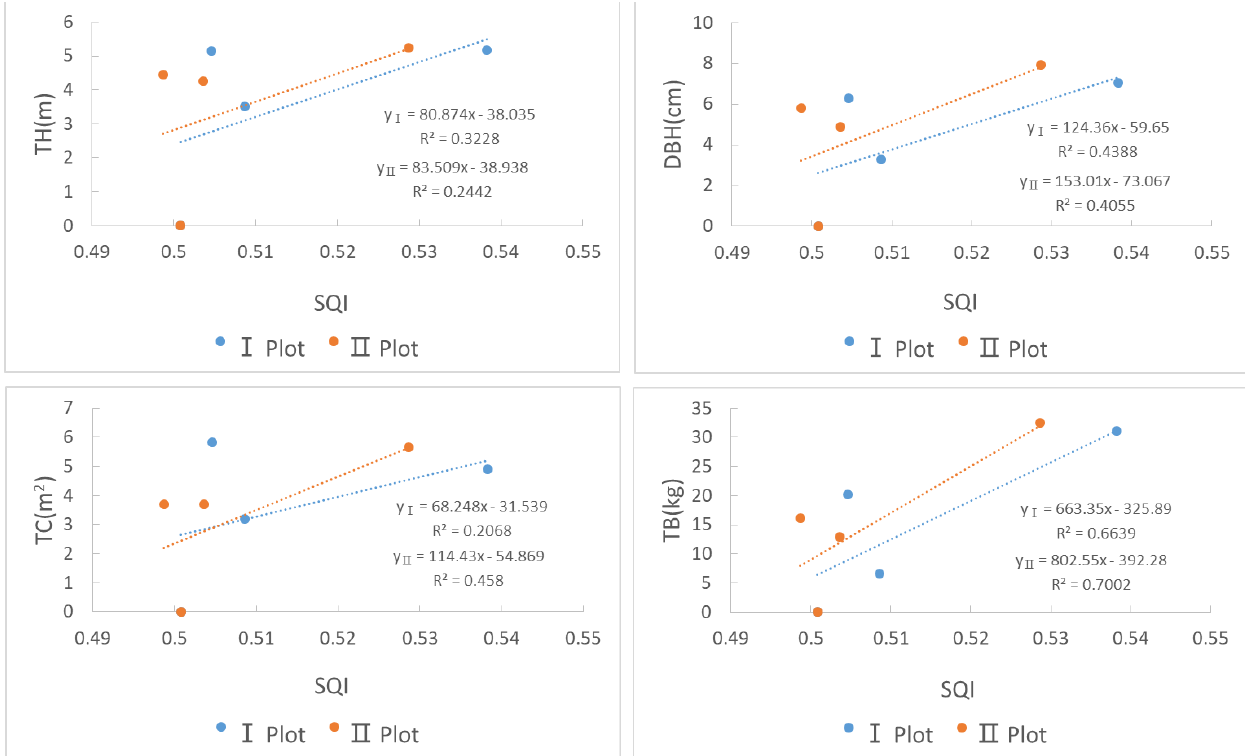
Figure 8. Correlation between Soil Quality Index and plant growth parameters.